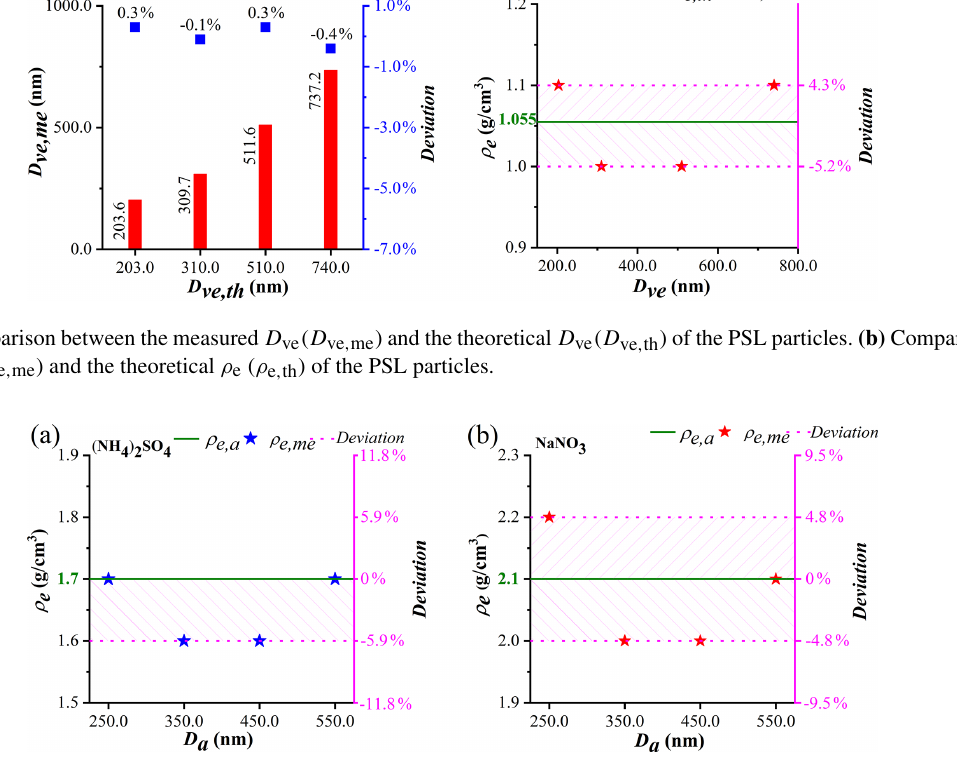
Figure 3. (a) Comparison between the measured ρ e ( ρ e , me ) and average ρ e ( ρ e , a ) values of the (NH 4 ) 2 SO 4 particles. (b) Comparison between the measured ρ e ( ρ e , me ) and average ρ e ( ρ e , a ) values of the NaNO 3